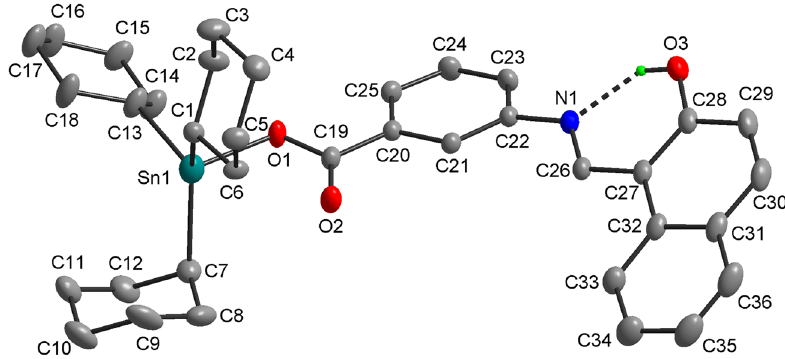
Figure 6: The molecular structure of 6. Ellipsoids are drawn at 30% probability level. Hydrogen atoms are omitted for clarity except H 3 atoms.